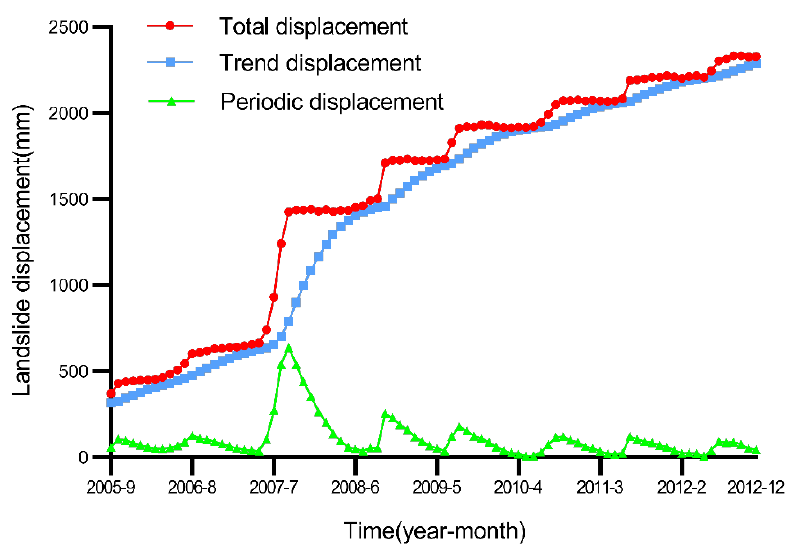
Figure 7. Decomposition results of the displacements measured at station ZG118.